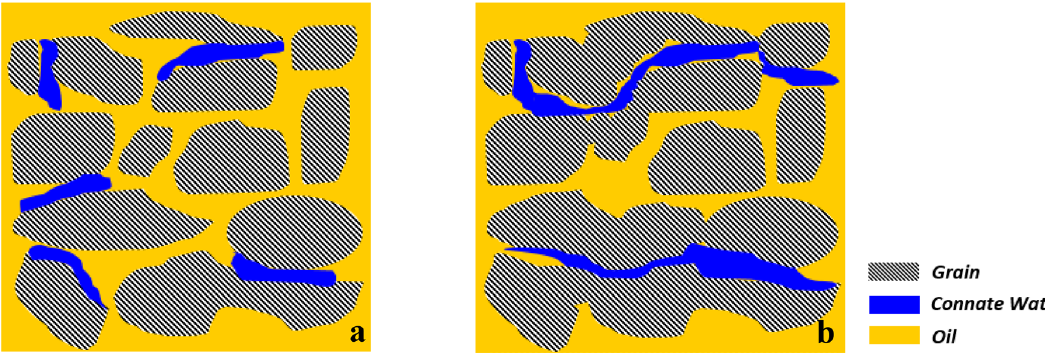
Fig. 4 Schematic of two various types of connate water distribution in the